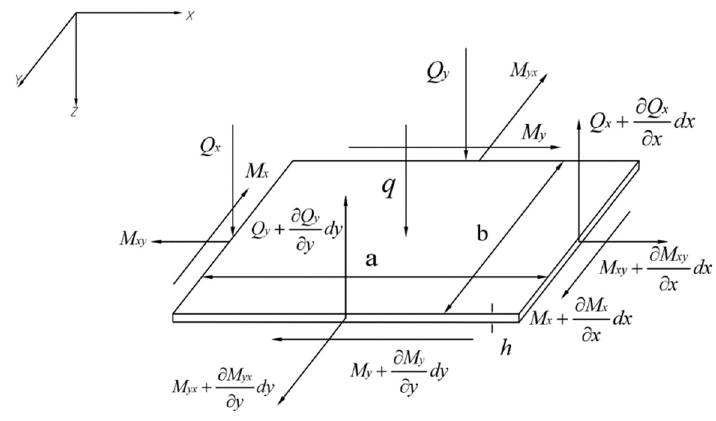
Figure 1. Loading and geometry of a thin, rectangular micro-plate model.